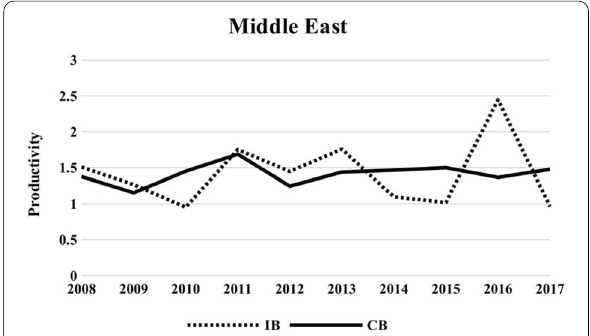
Fig. 2 Levels of productivity by years in Middle East